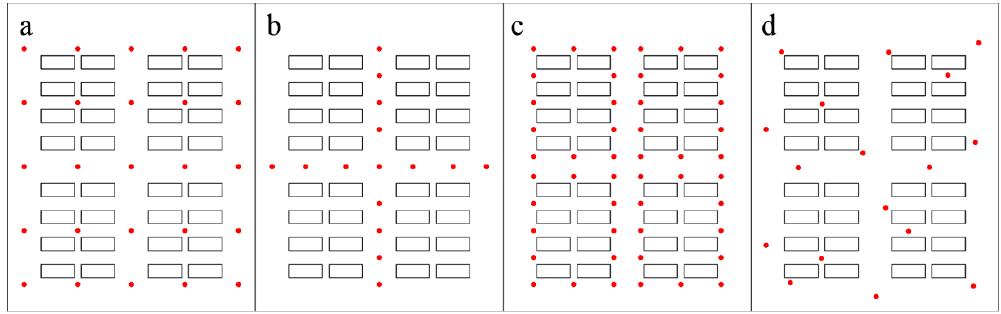
Figure 1. Four main arrangements of the wind tunnel measurement points. Display of ( a ) the arrays arrangement, ( b ) along streets arrangement, ( c ) around buildings arrangement, and ( d ) the distributed arrangement. Red dots represent the measurement points.